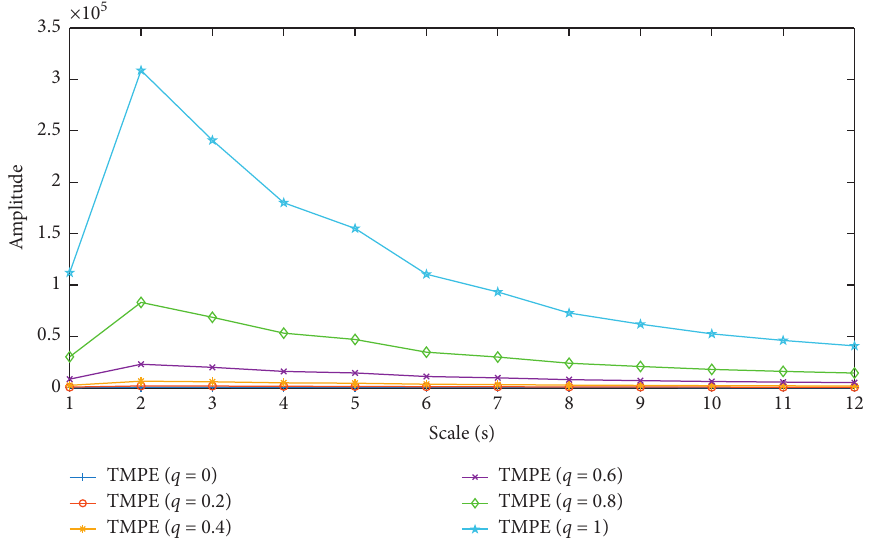
Figure 3: Effects of negative entropy index q on MTPEs.